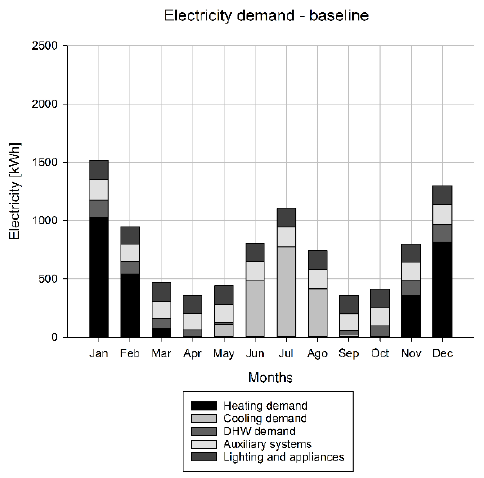
Figure 2. Electricity demand—baseline model results